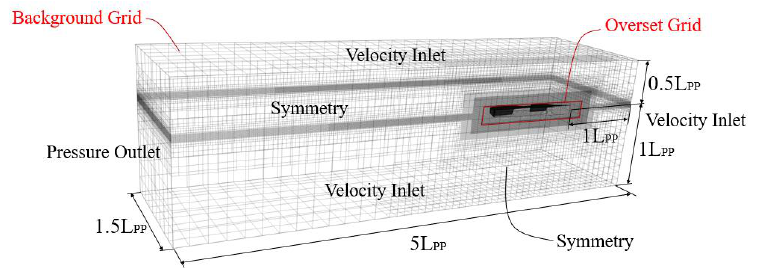
Figure 3. Calculation domain size and boundary conditions.